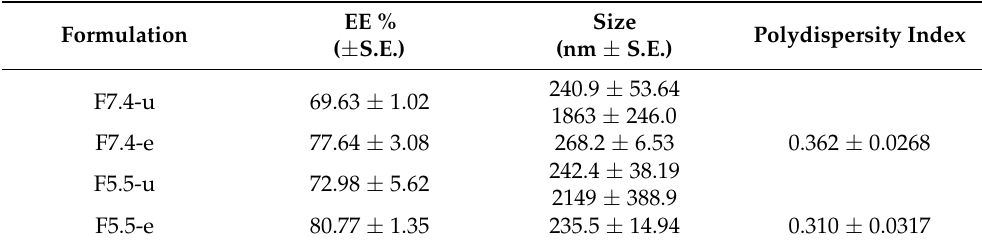
Figure 3. FTIR spectrum of F7.4-e ( A ) and F5.5-e ( B ) liposomal dispersions containing OLE/HP- β -CD co-precipitate dried in air using a micro-ATR accessory with a germanium crystal. The pictures show visible and FPA images of the compound: the infrared spectrum corresponds to the image pixel selected. Table 2. Physicochemical characteristics of the liposomal dispersions under study.